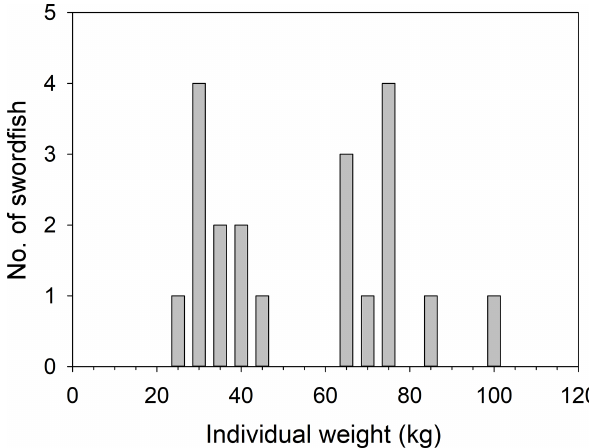
Figure 4. Example of individual weights of swordfish caught as bycatch in bluefin tuna traps located at F + F, Italy. These data are for the 20 swordfish caught on 20 separate fishing days in 1946. Similar data are available for a total of 1592 swordfish caught during 1931–2010 (see also Table 2 and online data files at Pangaea, https: //pangaea.de/, last access: 5 December